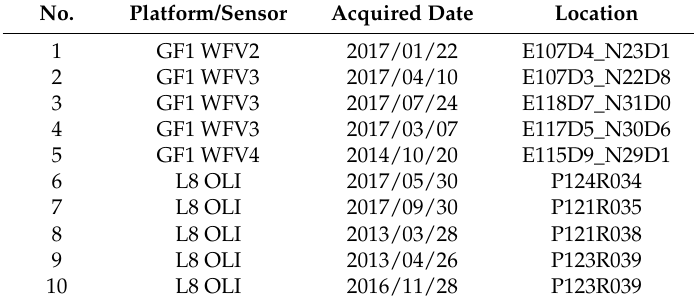
Table 1. The meta-information of the test data; the location is indicated using the image center (i.e., latitude and longitude) for the images acquired by the Wide Field View (WFV) onboard the Gao Fen 1 (GF1) and the path/row in the World Reference System coordinates for images captured by the Operational Land Imager (OLI) onboard the Landsat 8